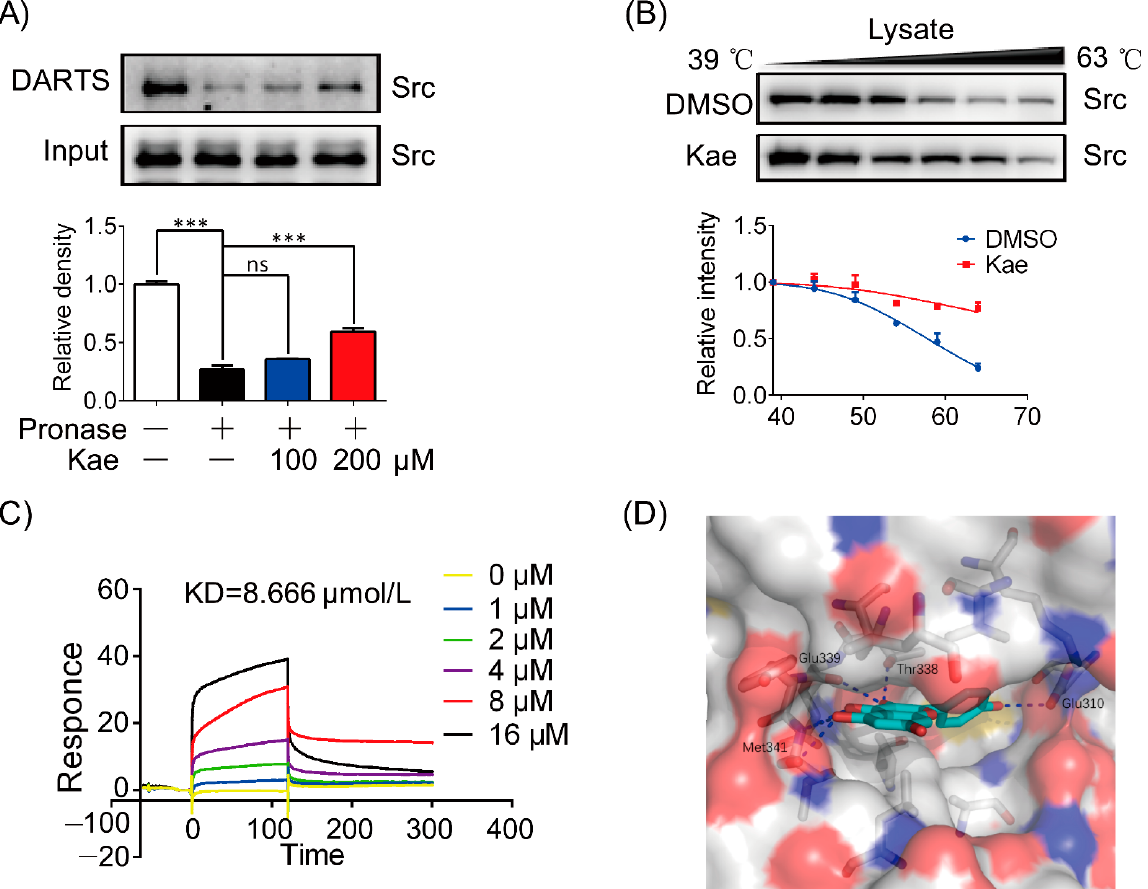
Figure 3. Identification and validation of Src as a direct target for Kae. ( A ) Immunoblot analysis of Src treated with DARTS assay ( n = 3). ( B ) Immunoblot analysis of Src degradation insult by indicated temperature (n = 3) . ( C ) Surface plasmon resonance (SPR) analysis of the interaction between Kae and Src: KD = 8.666 μ mol/L (n = 3). ( D ) Predicted binding mode of Kae in the ATP-site of the Src catalytic domain. Protein is shown in surface, and key amino acids interacting with Kae are highlighted in stick representation. Kae is colored in cyan. Hydrogen bonds are depicted by blue dashed lines. *** p < 0.001 and ns, statistically not significant.